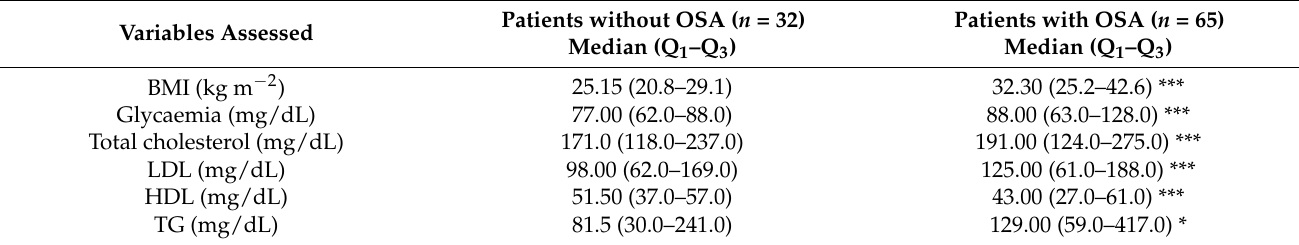
Table 1. Comparison between metabolic and sympathetic nervous system variables in patients with and without obstructive sleep apnea